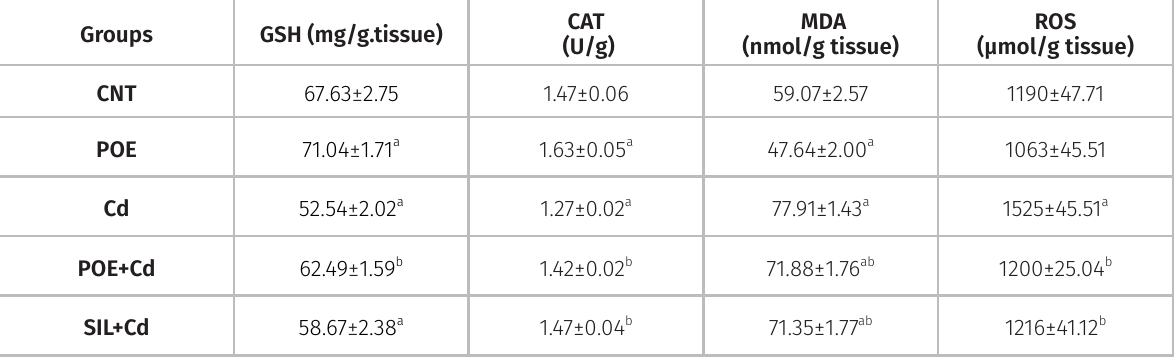
Table II. Effect of P. ostreatus methanolic extract (POE) / SIL on glutathione (GSH) level, catalase (CAT) activity, malondialdehyde level (MDA) and reactive oxygen species (ROS) level in renal tissue of Cd-intoxicated female rats.